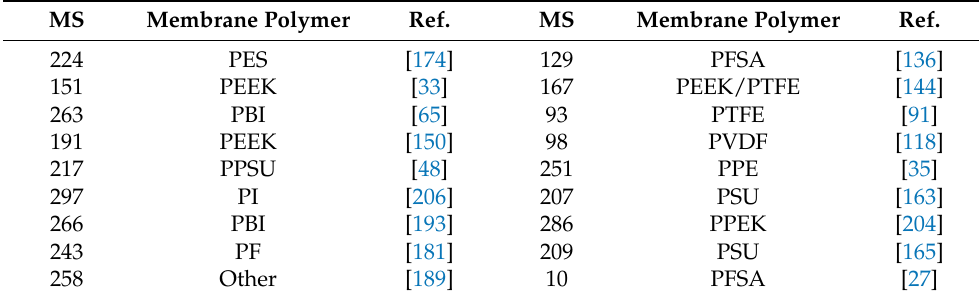
Table 17. Published low-cost